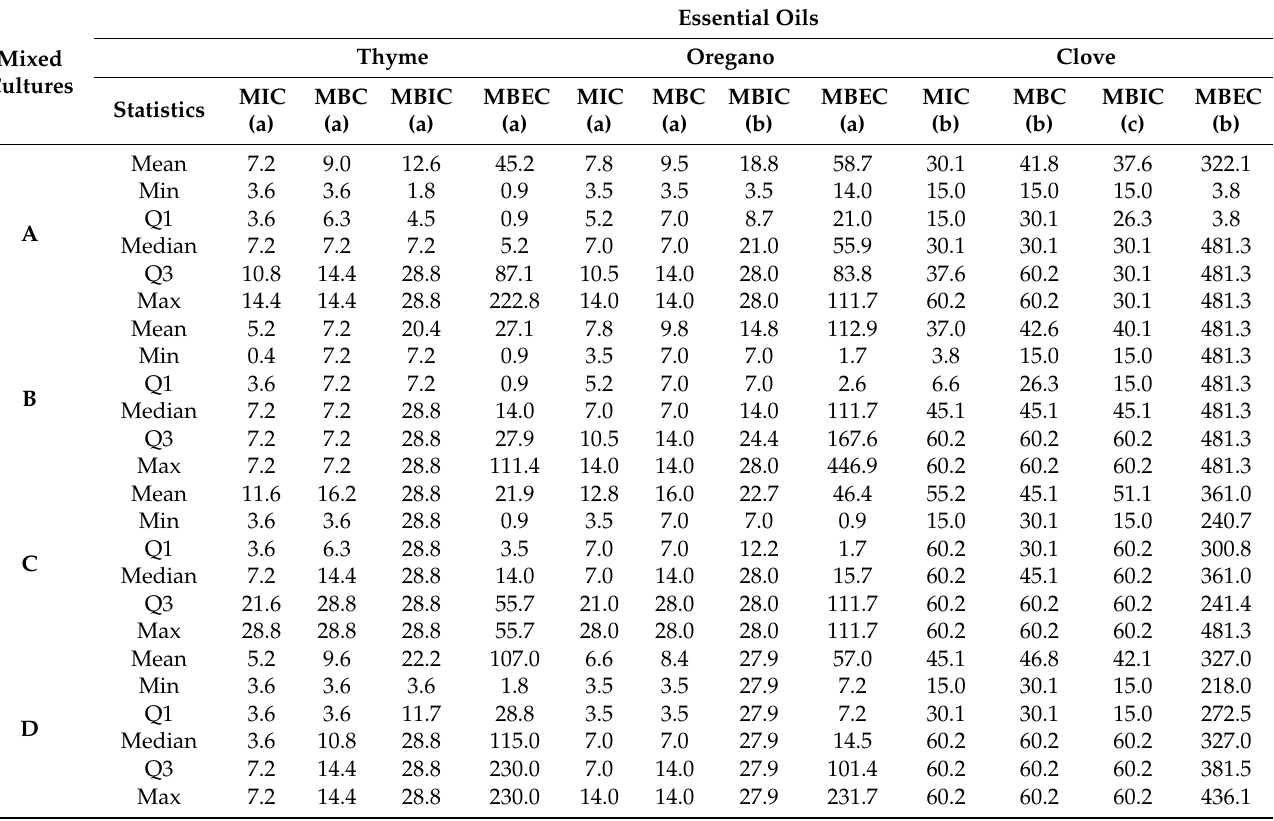
Table 1. Antimicrobial activity of the essential oils against mixed cultures (values displayed in mg/mL). Essential Oils Thyme Oregano Mixed Cultures